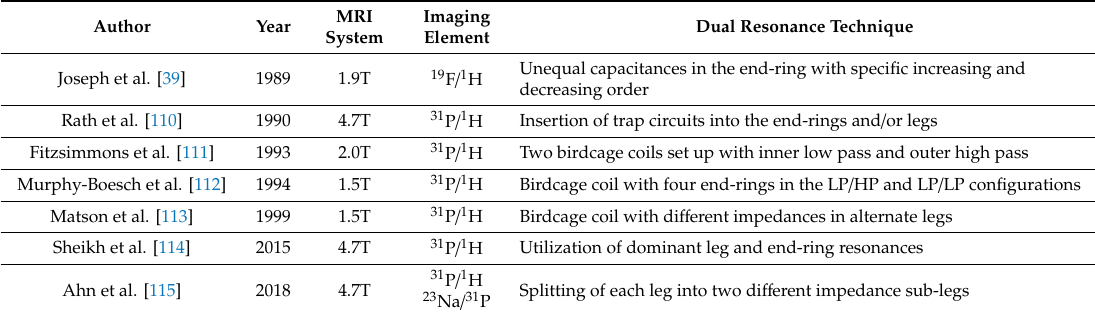
Table 3. Various techniques for the dual-resonant operation of the birdcage